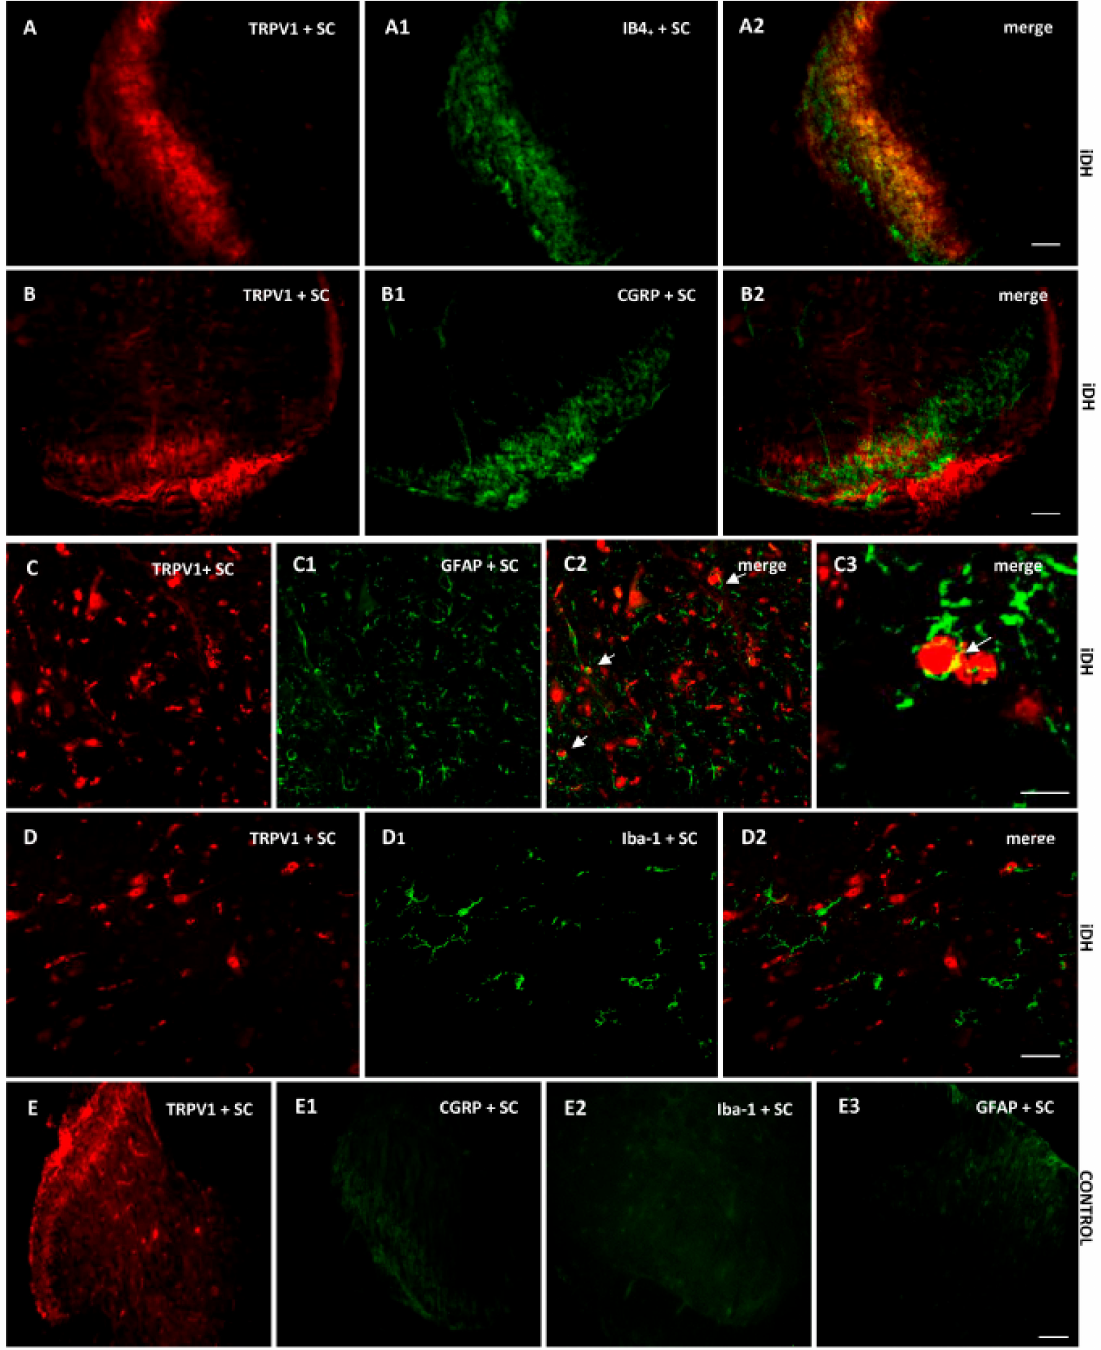
Figure 6. Cellular distribution of TRPV1 in the ipsilateral Dorsal Horn (iDH). Representative microphotographs by immunofluorescence of TRPV1 (red, A – D ) relative to IB4 + (green, A1 ), CGRP (green, B1 ) GFAP (green, C1 ), Iba-1 (green, D1 ) in the spinal cord (SC) of PSNL rats. TRPV1 colocalizes weakly with peptide (CGRP, B2 ), and more abundantly with non-peptide fibers (IB4 + , A2 ) and astroglia (GFAP, C2 C3 ), but not with microglia ( D2 ). The same markers are shown in iDH of control rats. Scale bar = 120 µ m (all panels, 10 × ), 60 µ m ( C – C2 and D – D2 , 20 × ), 75 µ m ( C3 , 60 ×